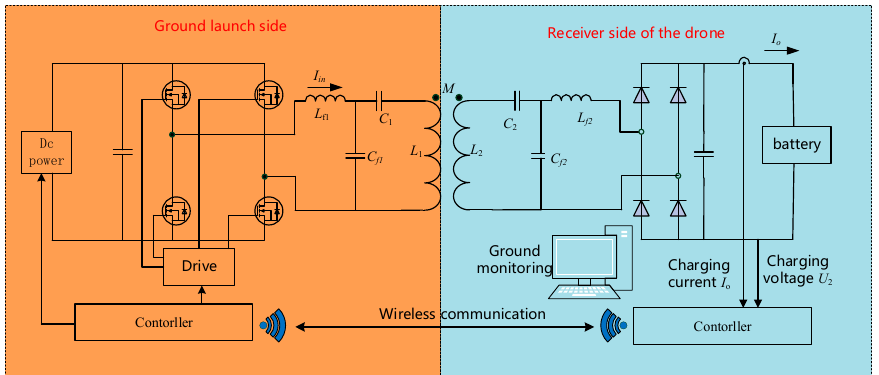
Figure 14. ( a ) Variation of the original side self-inductance. ( b ) Variation of the secondary side self- inductance.